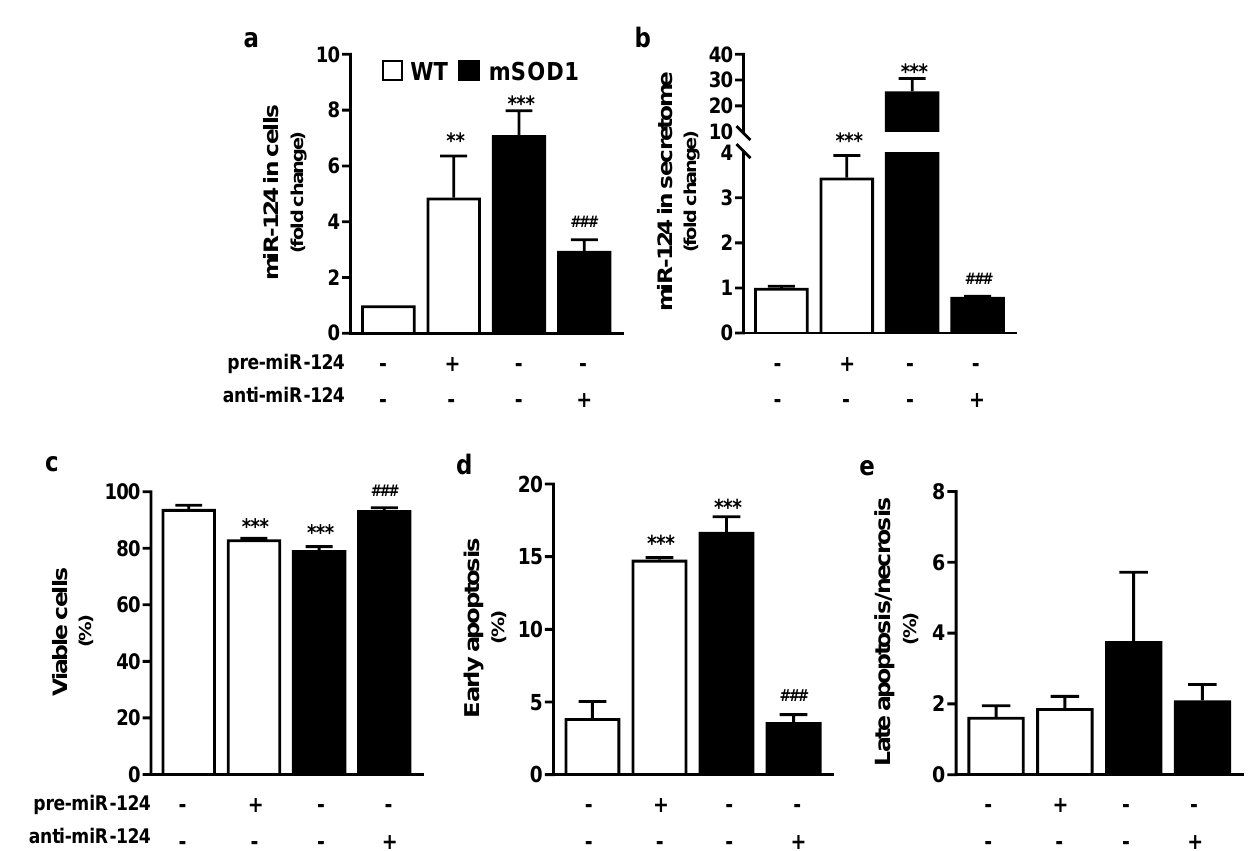
Figure 1. Upregulation of miR-124 in WT MNs increases cell death by apoptosis as occurs in mSOD1 MNs, which survival is restored by treatment with anti-miR-124. After 2 days of differentiation, NSC-34 WT and mSOD1 MNs were transfected with pre-miR-124 or anti-miR-124, respectively, for 12 h and maintained for additional 48 h. ( a , b ) Cells and derived secretome were collected for miRNA isolation and levels of miRNA-124 were evaluated by reverse transcriptase quantitative real-time PCR (RT-qPCR). SNORD110 and RN1UA1 were used as reference genes. ( c – e ) Percentage of viable, early apoptotic, and late-apoptotic/necrotic cells were determined by flow cytometry with phycoerythrin-conjugated annexin V (annexinV-PE) and 7-amino-actinomycin D (7-AAD). The three populations were distinguished as follows: ( c ) viable cells (annexin V-PE and 7-AAD negative); ( d ) early apoptotic cells (annexinV-PE positive and 7-AAD negative); and ( e ) cells in late stages of apoptosis or necrosis (annexinV-PE and 7-AAD positive). Results are mean ± SEM from at least six independent experiments and expressed as fold change vs. WT MNs ( a , b ), or as percentage per total number of counted events ( c – e ). *** p < 0.001 and ** p < 0.01 vs. WT MNs; ### p < 0.001 vs. mSOD1 MNs; one-way ANOVA followed by multiple comparisons Bonferroni post-hoc correction. MNs, motor neurons; mSOD1, MNs overexpressing G93A mutation in superoxide dismutase 1; WT, wild type.